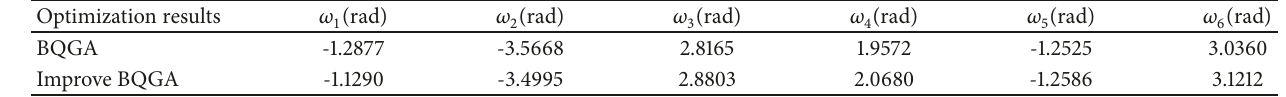
Table 2: Optimization results of BQGA and improved BQGA.